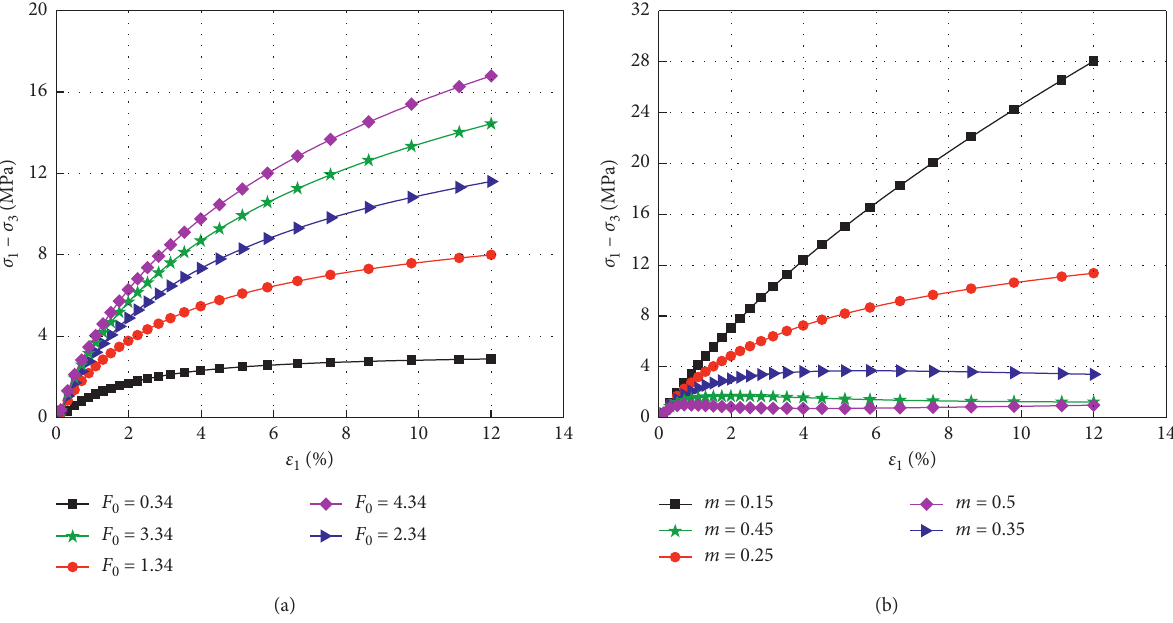
Figure 10: The relationship between the damage constitutive model of frozen sand and F